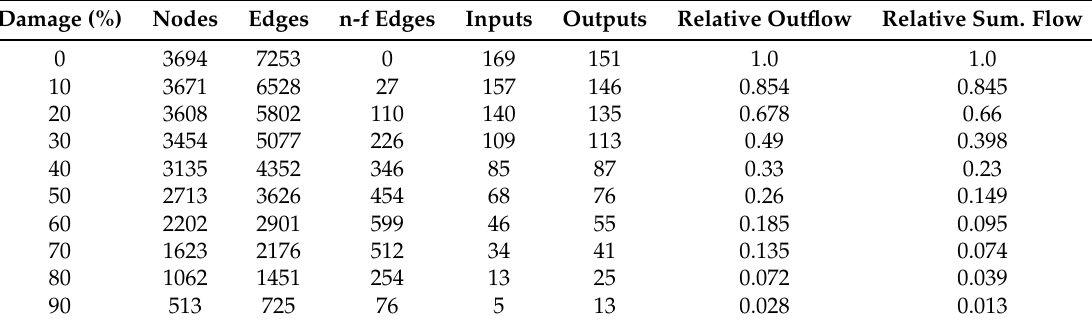
Table 4. System degradation for gradient boundary conditions.